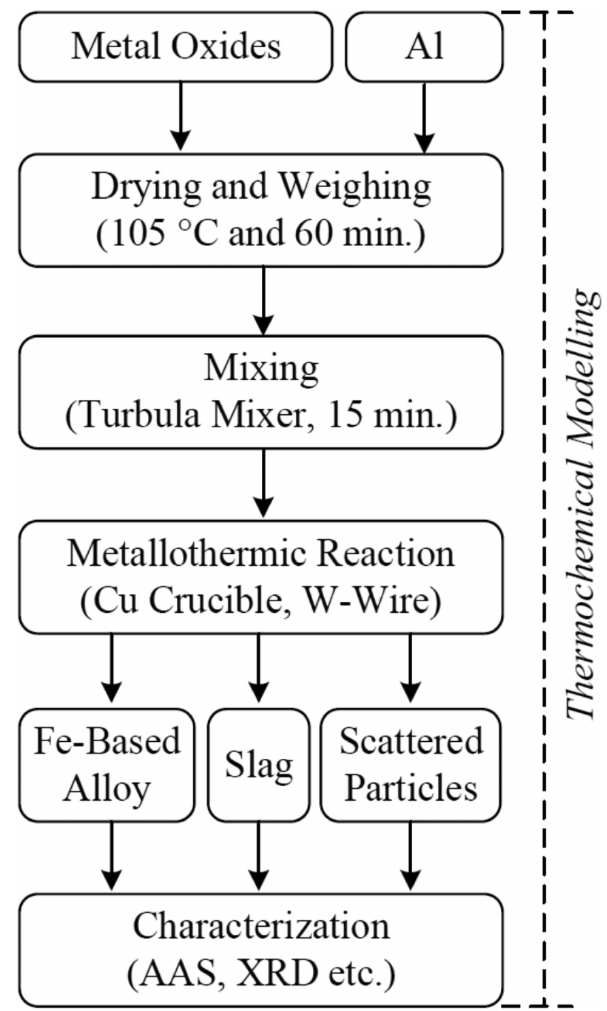
Figure 1: Flowchart of the experimental